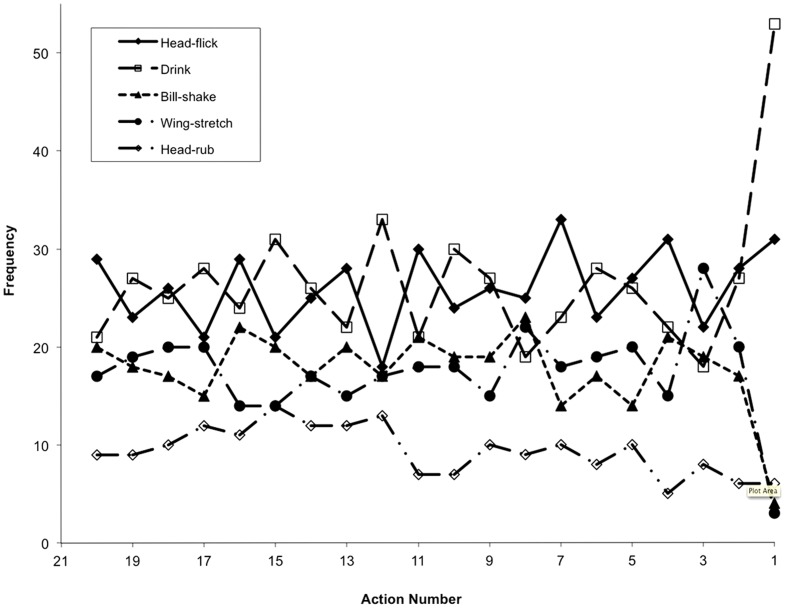
The frequency distributions of five specific actions in sequences leading to copulation from action 20 (that nearest the start of the sequence for long sequences and action 8 for the short sequences) to action 1 (that at the end of the sequence).The data are taken from the 189 primary sequences leading to copulation.